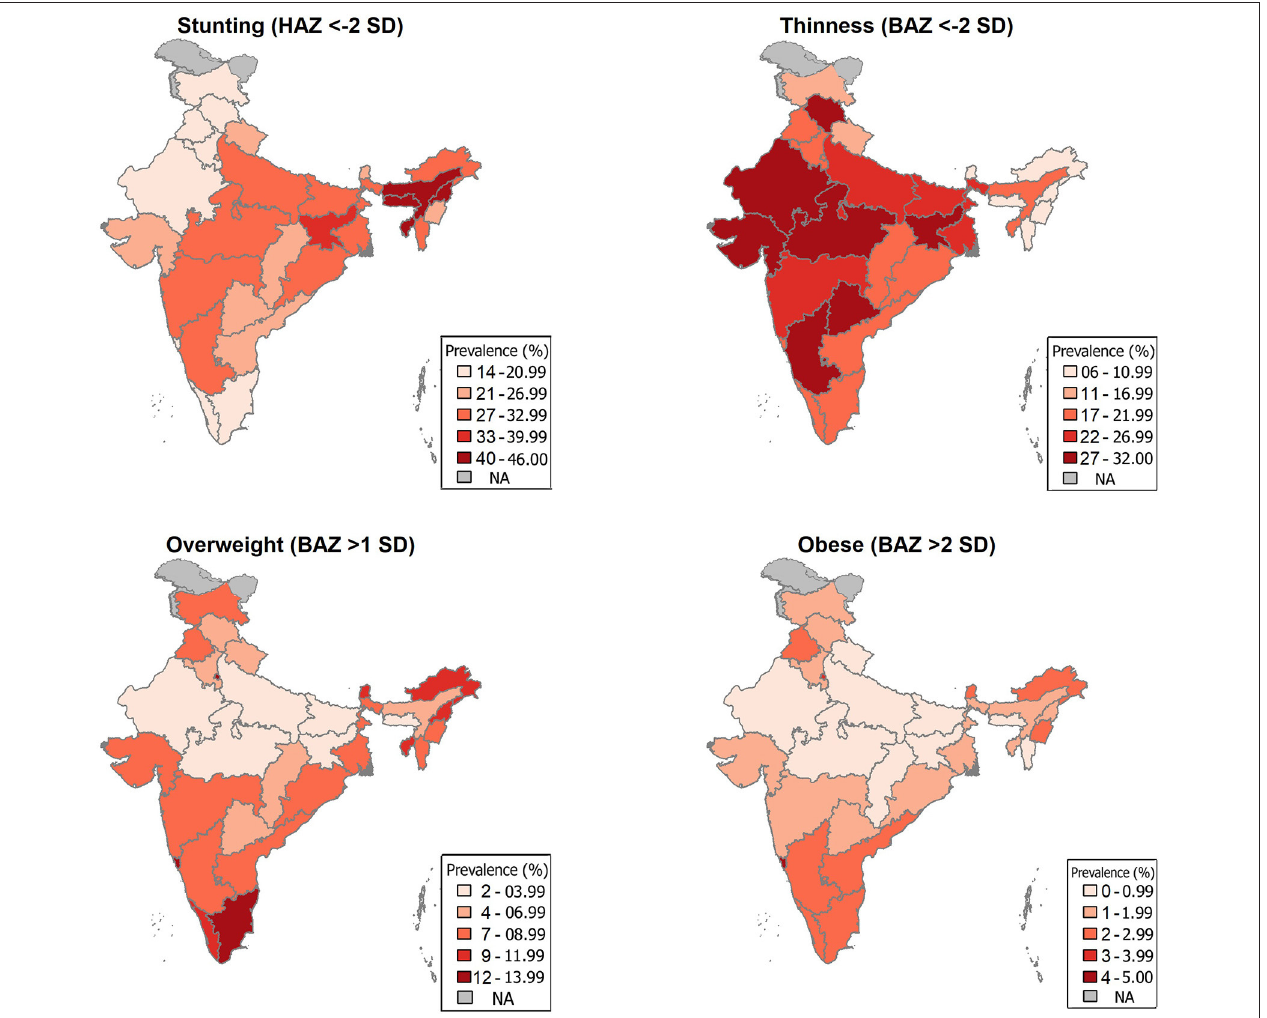
FIGURE 2 | State-wise burden of Stunting, Thinness, Overweight, and Obesity among Indian children aged 10–19